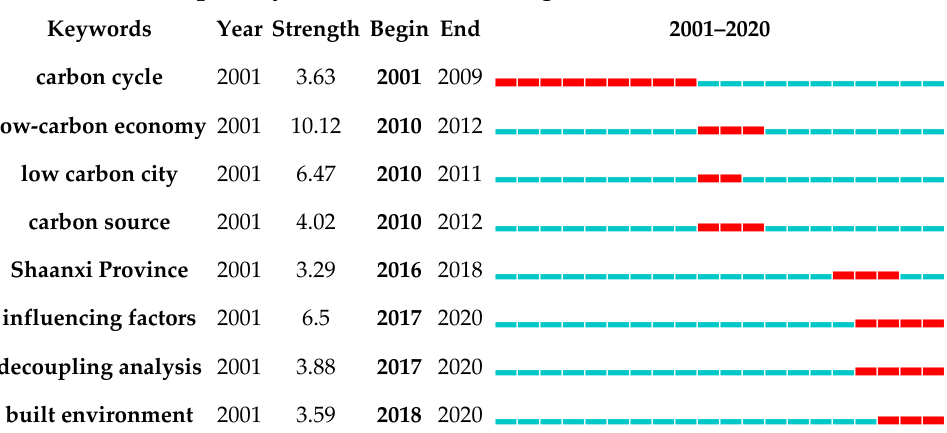
Figure 12. Burst intensity map of keywords for carbon emissions research in the CNKI database